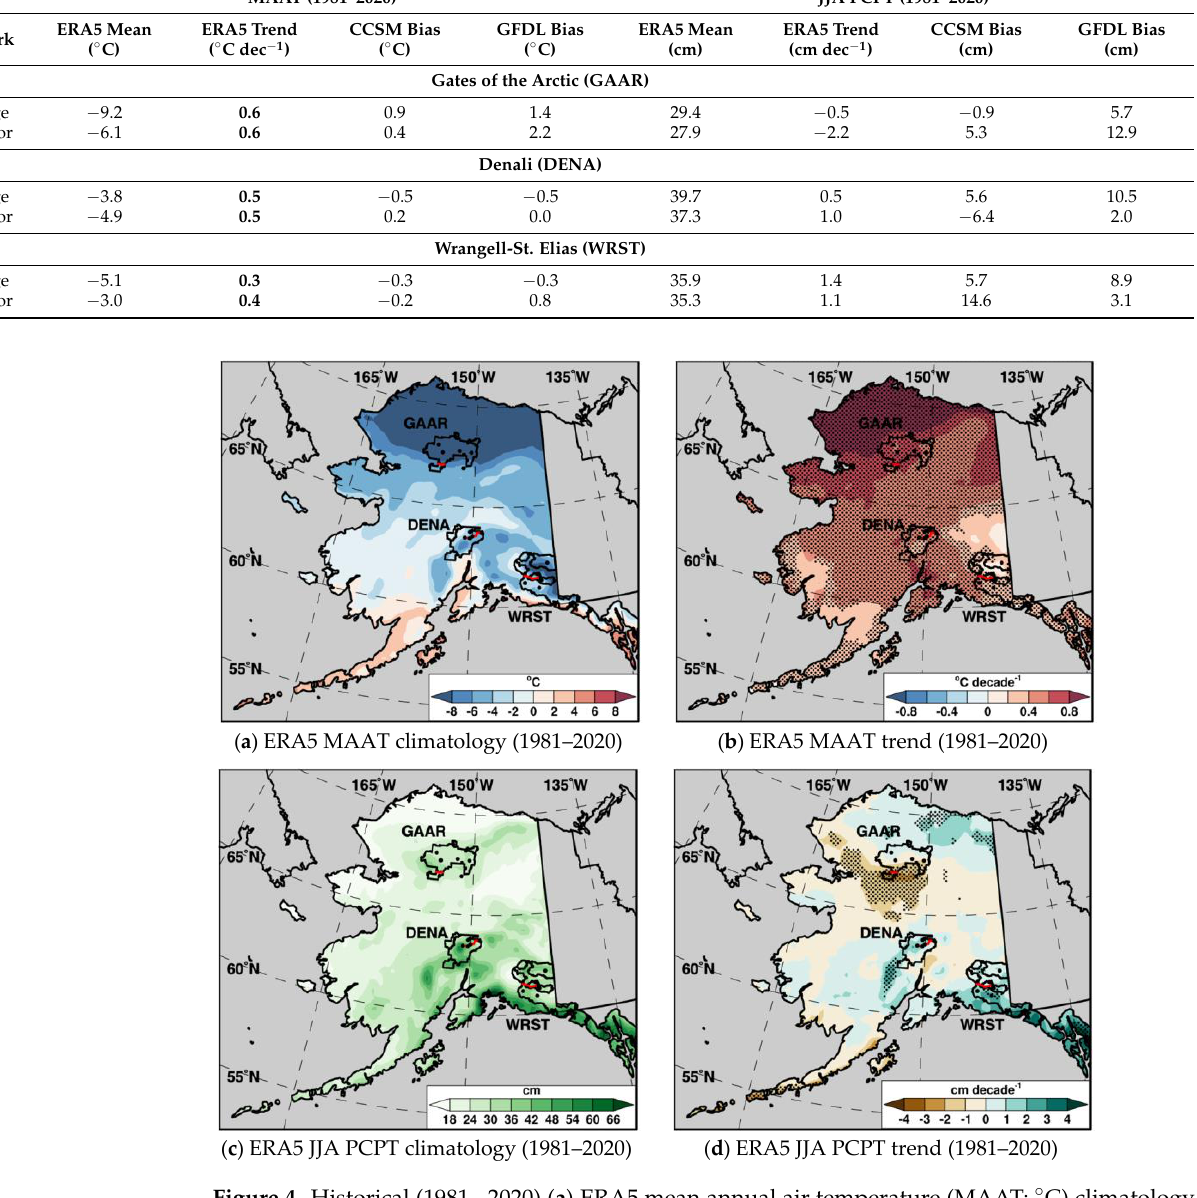
Figure 4. Historical (1981 − 2020) ( a ) ERA5 mean annual air temperature (MAAT; °C) climatology, ( b ) ERA5 MAAT trend (°C decade − 1 ), ( c ) ERA5 summer precipitation (JJA PCPT; cm) climatology, and ( d ) ERA5 JJA PCPT trend (cm decade −1 ). Significant trends at the 95% confidence level are shaded with stippling.